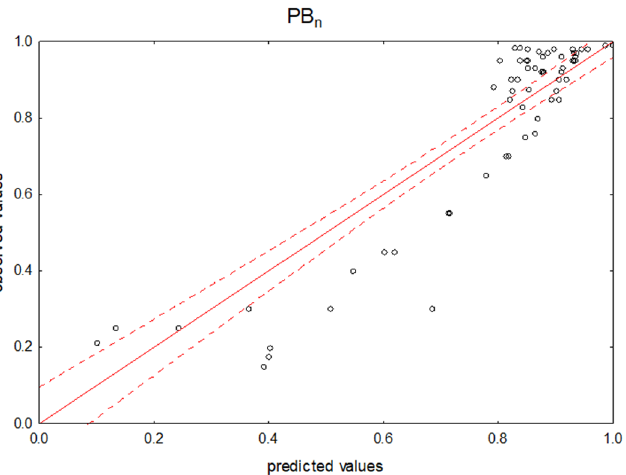
Figure A3. Predicted vs. observed values for MLR model using NP TLC retention data. Dependent variable: PB n